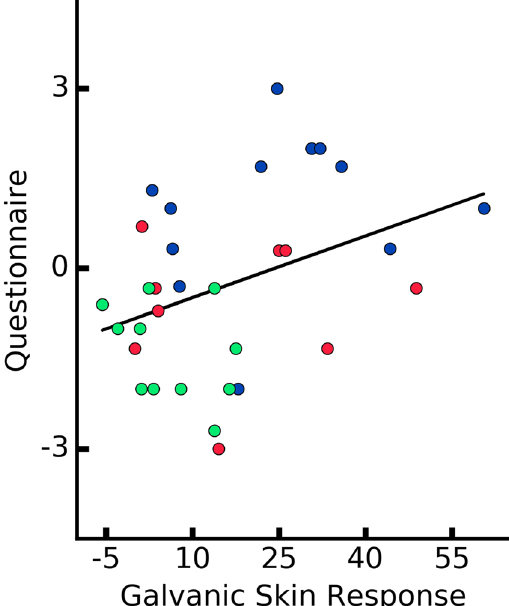
Figure 10. Correlation between the post-threatening galvanic skin response signal and self-reports. Every data point represents a